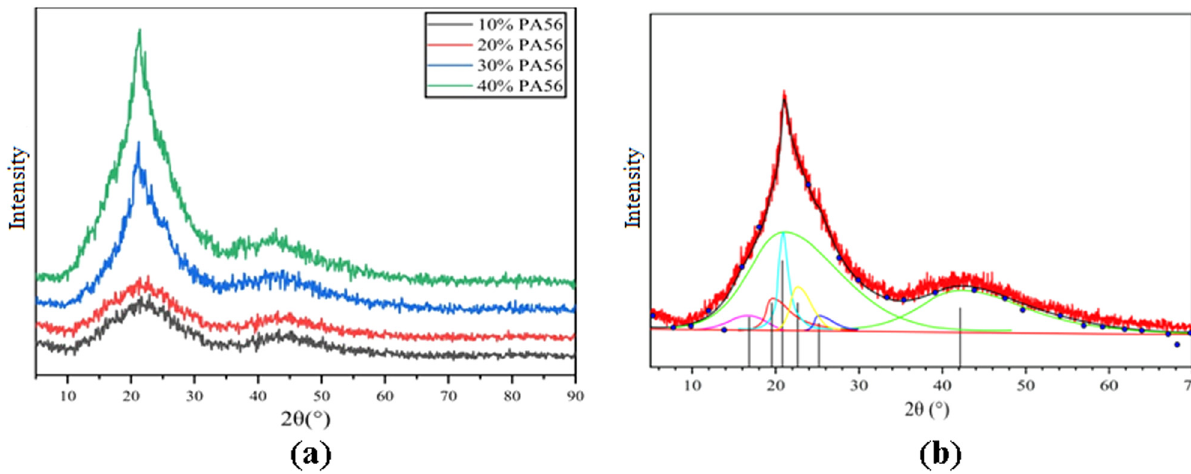
Figure 9: XRD test results of bio - based PA56/PET blends: ( a ) XRD test curves and ( b ) schematic diagram of XRD - peak - di ff erentation.